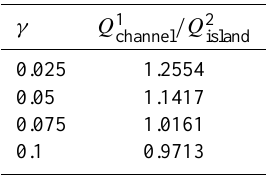
Table 2. Effect of the parameter γ on the flux distribution between channels and islands. Detailed cross-section locations are given in Fig. 14.